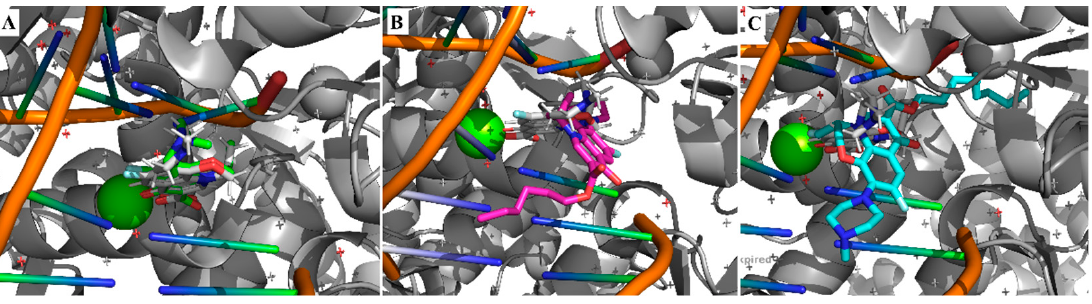
Figure 2. Top pose obtained from the docking of levofloxacin ( A ), hexyl ester of LEV ( B ) and nonyl ester of LEV ( C ).